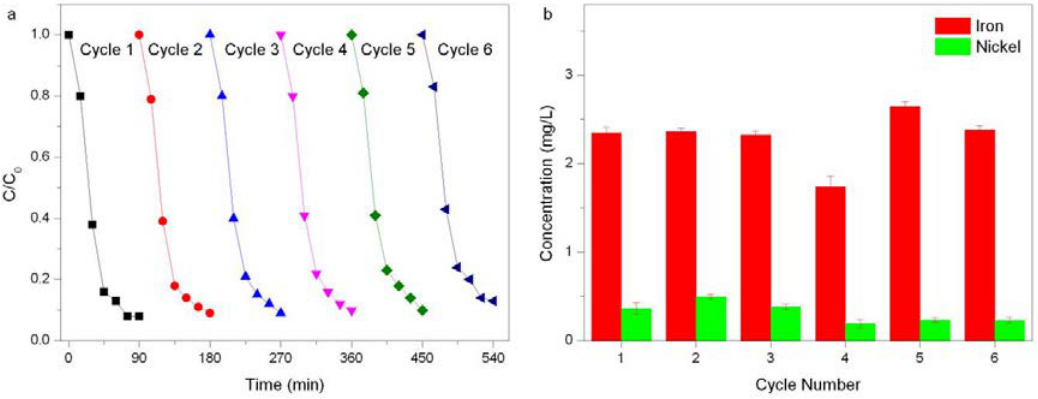
Figure 6. Recycling experiments of Fe-Ni/MAC ( a ) and corresponding leaching of iron and nickel ( b ) performed under optimal conditions: catalyst 10 g/L, ozone 68 mg/L, pH 9 and reaction time 90 min.